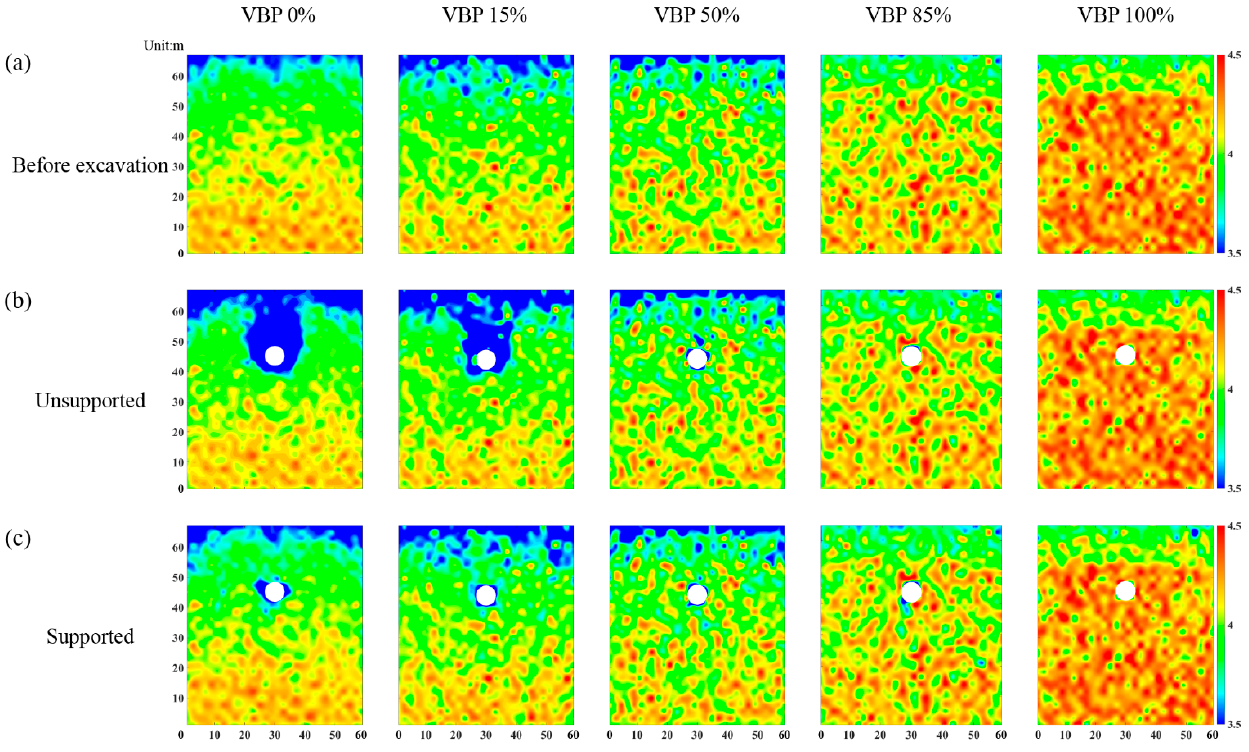
Figure 8. The coordination number distribution in the ( a ) original state, ( b ) excavation without support and ( c ) supported excavation by lining.